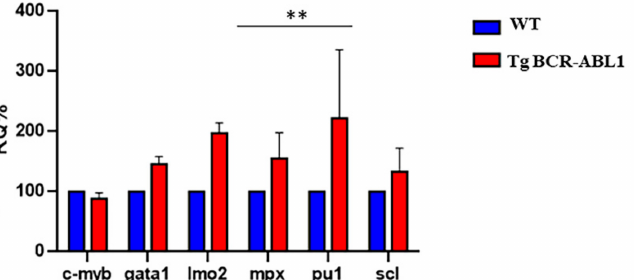
Figure 3. Expression level analysis of hematopoiesis markers. RT-PCR for transcript quantification of six known genes involved in hematopoiesis process. Gene expression was normalized using α elongation factor1 as a reference gene and expressed as relative quantification (RQ). Blue bars represent wild type; red bars represent Tg BCR-ABL1. Statistical analysis was performed by unpaired t -test; ** p <